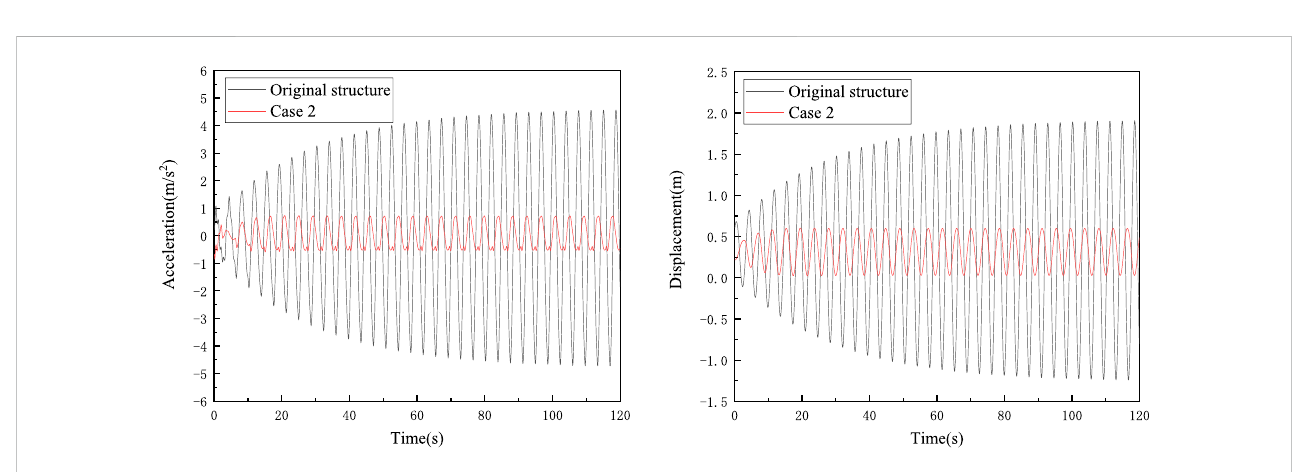
FIGURE 10 The acceleration and displacement control effectiveness when stiffness ratio is .8 under steady-state ice force.